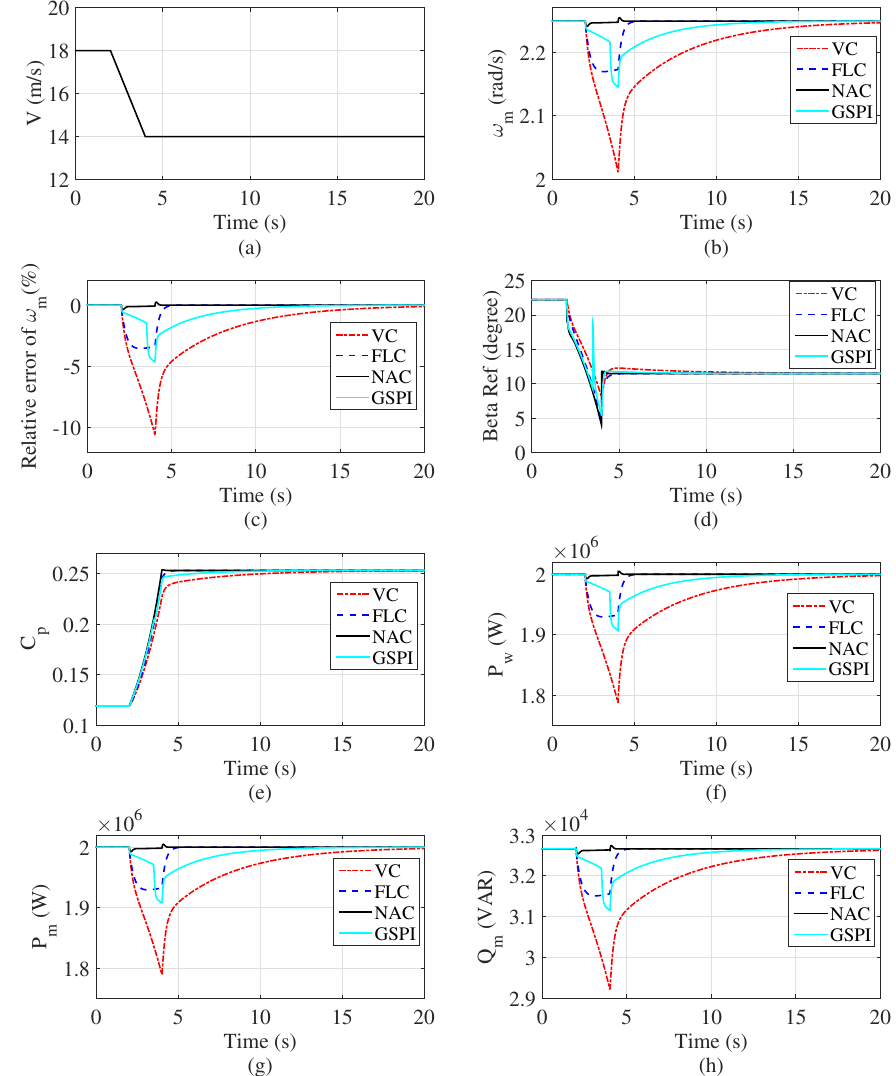
Figure 5. Responses of the PMSG-WT to ramp wind speed. ( a ) Wind speed V. ( b ) Mechanical rotation speed ω m . ( c ) Relative error of ω m . ( d ) Required pitch angle. ( e ) Power coefficient C p . ( f ) Mechanical power P w . ( g ) Active generating power P m . ( h ) Reactive generating power Q m